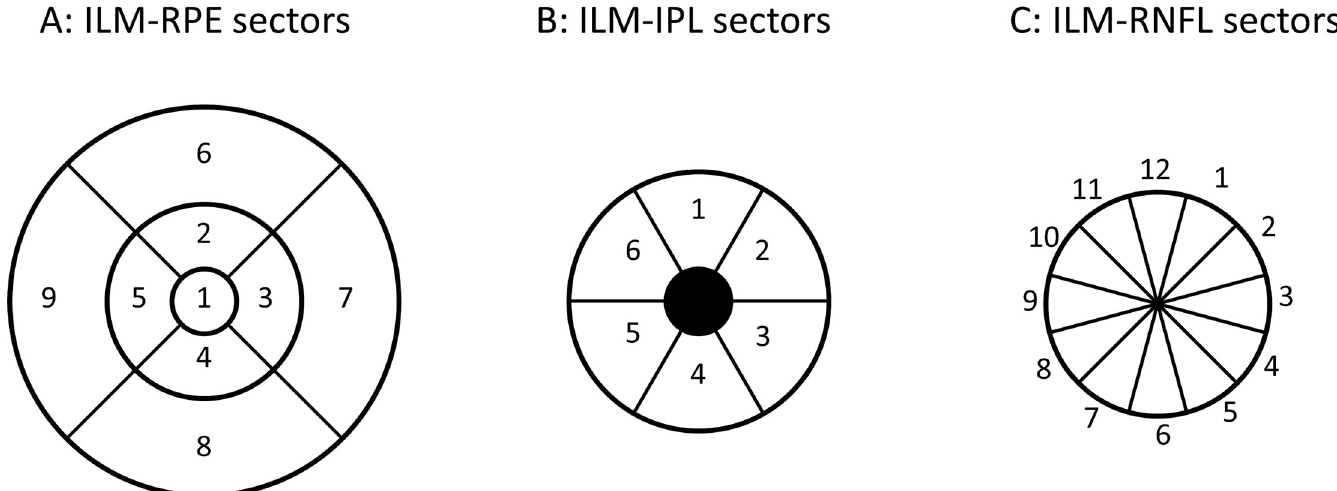
Fig 1. Schematic representation of the sectors for the retinal layer thickness. In A ILM-RPE represents inner limiting membrane to retinal pigment epithelium thickness and numbers 1 to 9 indicate Center, inner superior, inner nasal, inner inferior, inner temporal, outer superior, outer nasal, outer inferior and outer temporal sectors. In B, ILM-IPL represents inner limiting membrane to inner plexiform layer thickness and numbers 1to 6 indicate superior, superior nasal, inferior nasal, inferior, inferior temporal and superior temporal sectors. In C, ILM-RNFL represents inner limiting membrane to retinal nerve fiber layer thickness and the numbers represent the clock hour position of the sectors. A and B are from the macular scans and C is from the optic disc scan.